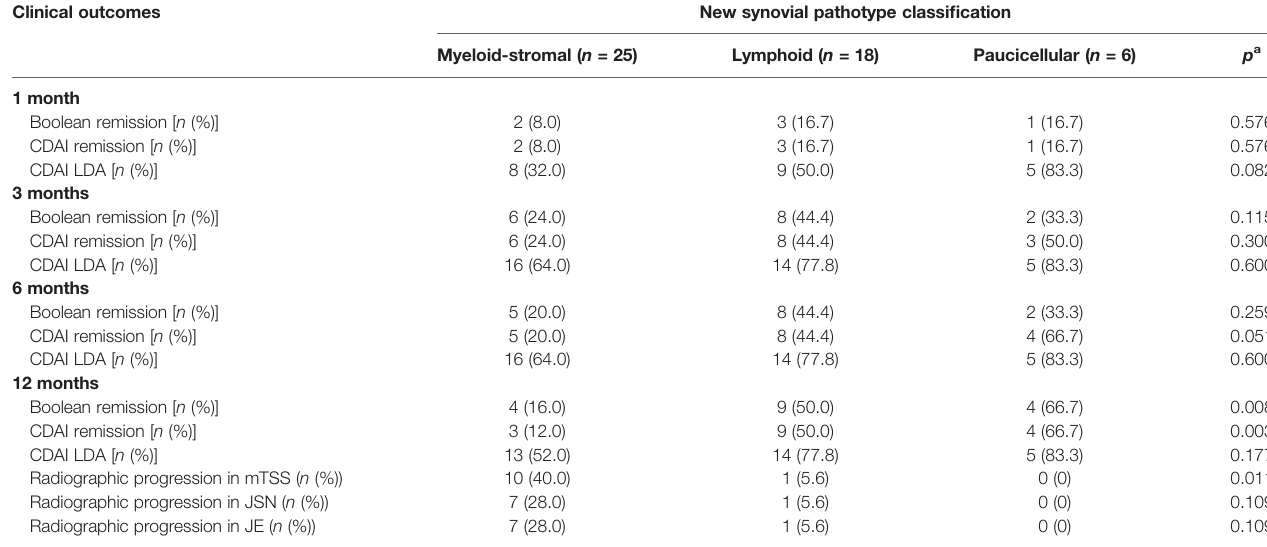
TABLE 4 | Clinical outcomes in treatment-naive RA patients with different synovial pathotypes during a 1-year follow-up. Clinical